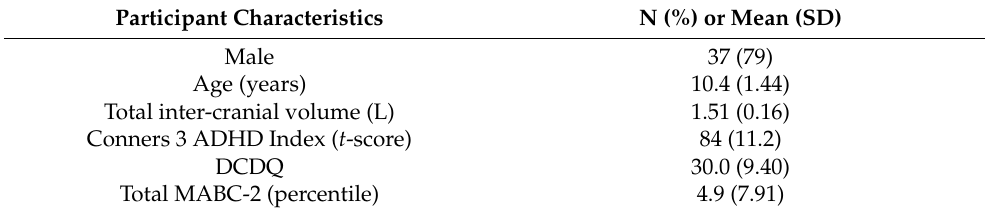
Table 1. Participant characteristics ( n =